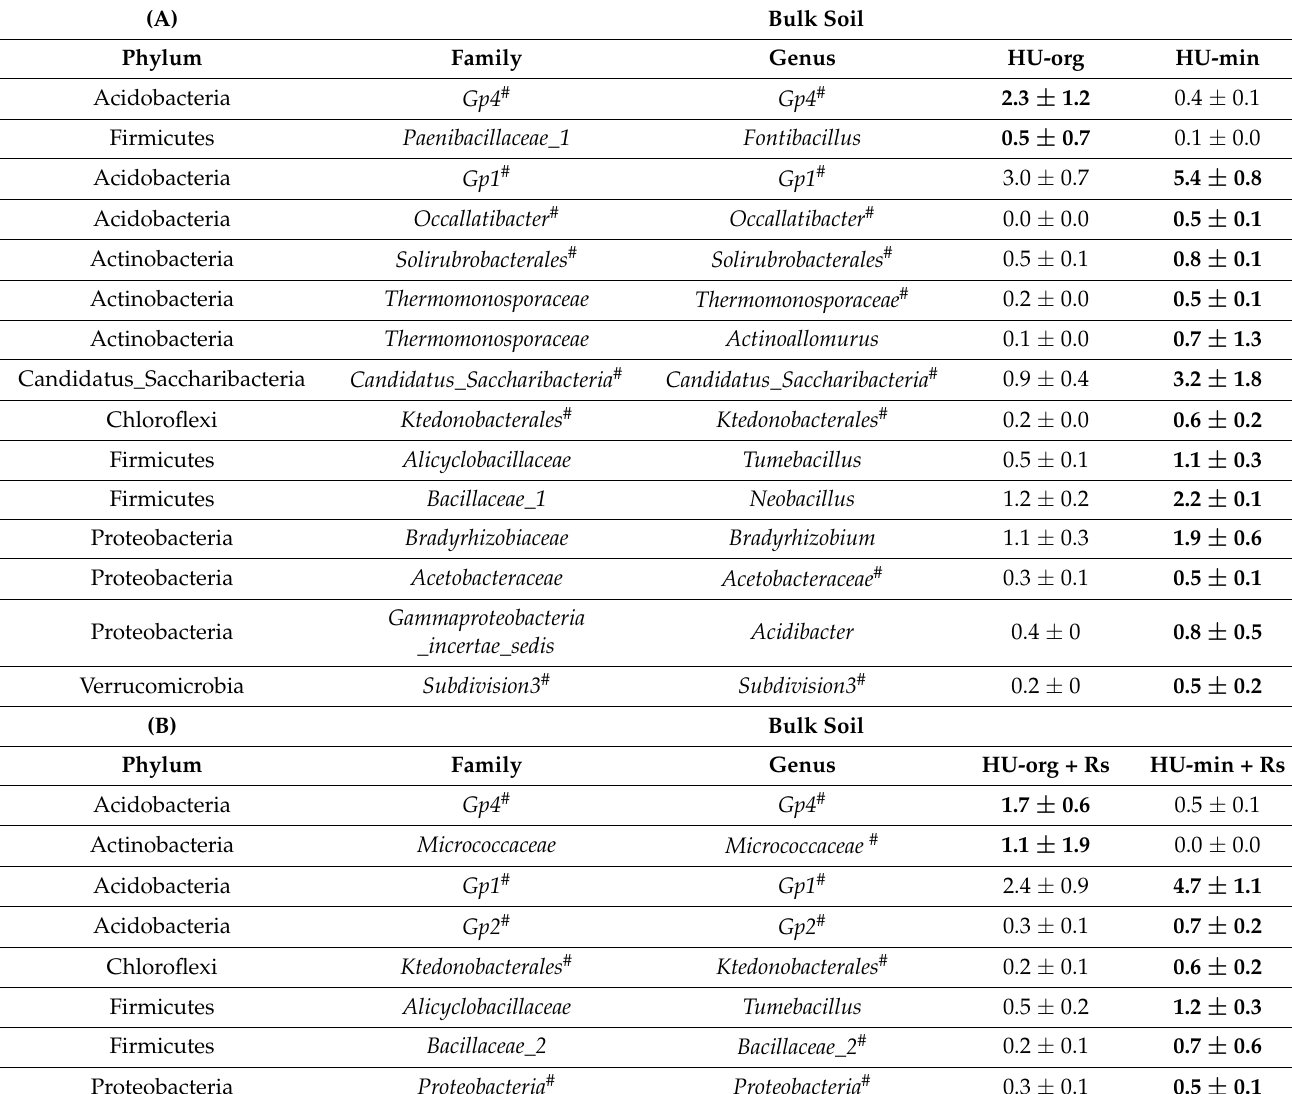
Table 3. Bacterial genera in bulk soils differing significantly (FDR < 0.05) in relative abundance depending on long-term organic (HU-org) and mineral (HU-min) fertilization strategy ( A ) in the absence and ( B ) in the presence of Rhizoctonia solani AG1-IB (+Rs). Mean ± standard deviation of taxa with >0.5% relative abundance is displayed. Bold numbers indicate significant